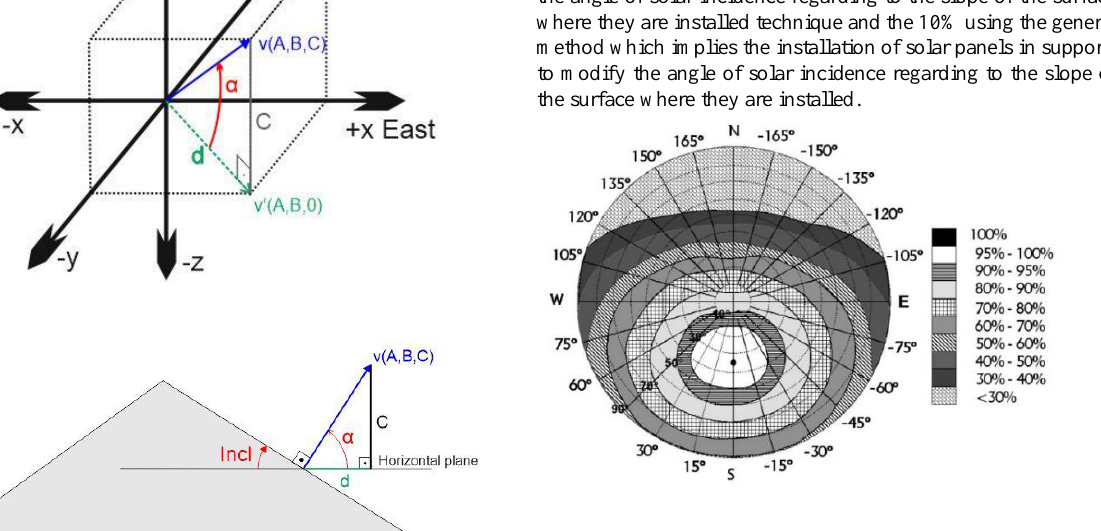
Figure 10: Diagram for the estimation of solar losses by orientation and inclination (Latitude 41º) (IDAE). The radial Figure 9: Inclination of the slope from the values of the normal lines set the orientation of the surface. The concentric circles vector of the plane. sets the slope of the surface. The texture found in the intersection of these parameters gives the losses by inclination and orientation of the roof (Source: IDAE).